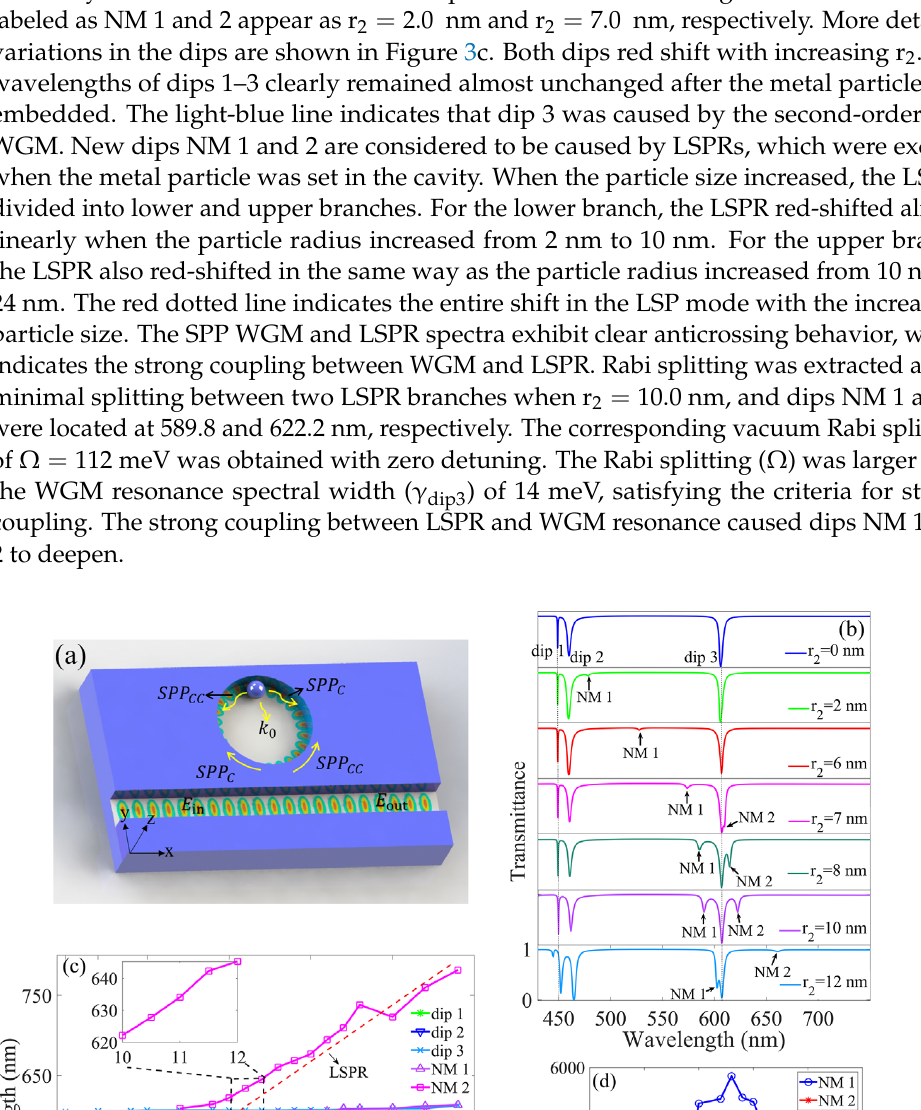
). ( d ) Near-field enhancement r 2